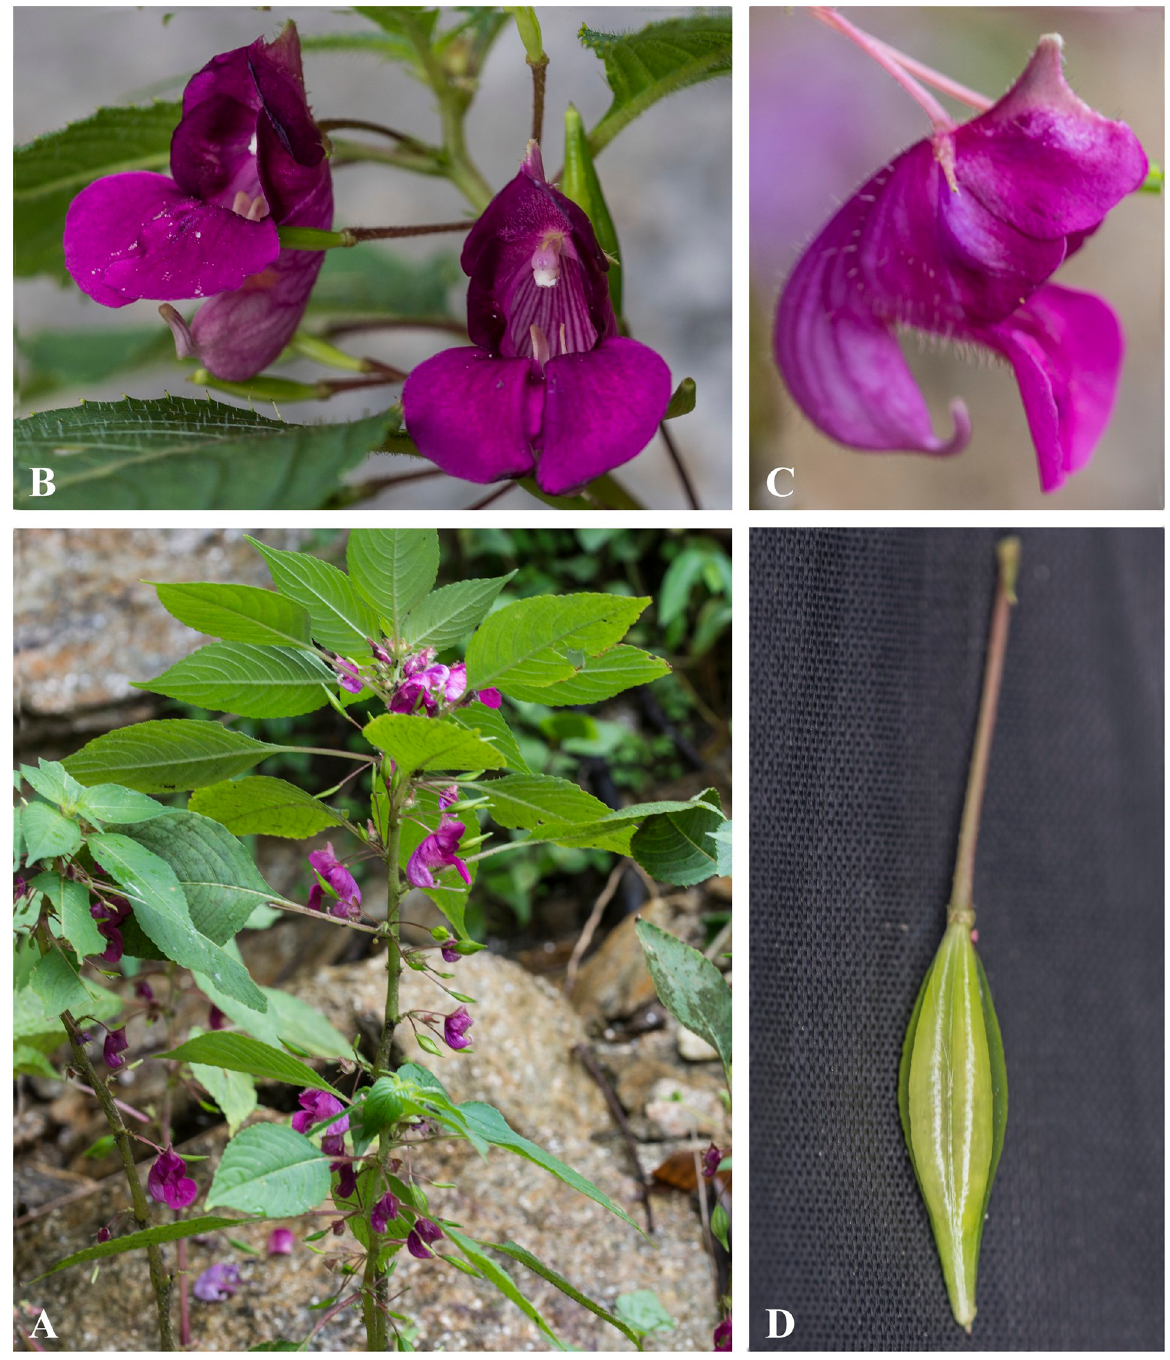
Fig 32. Impatiens tripetala A. Flowering plant; B. Flower (Front view); C. Flower (side view); D. Capsule. Photographs by Bhakta Bahadur Raskoti.